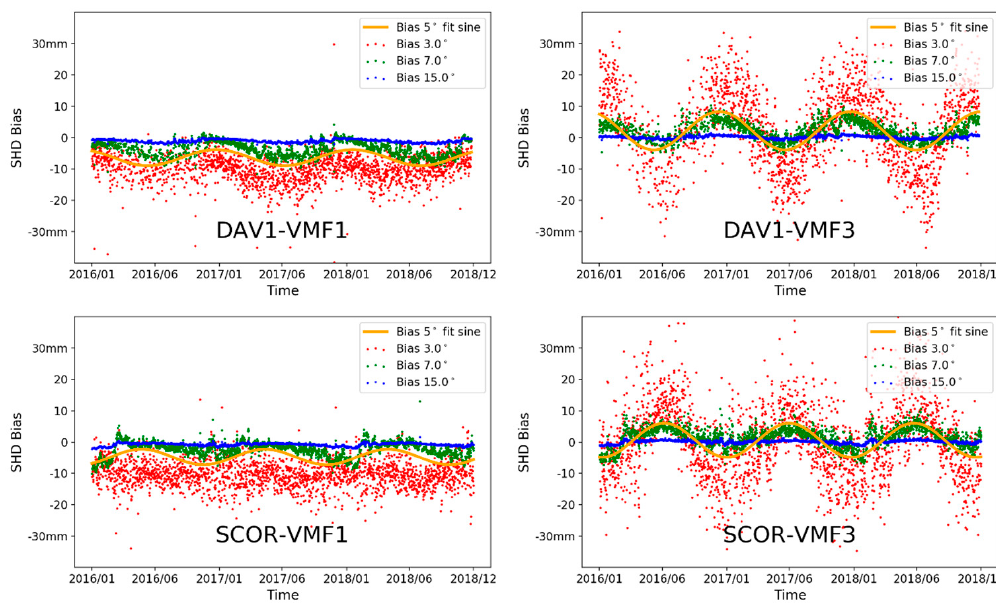
Figure 10. Time series of the biases between VMF1 and VMF3 SHD estimates with respect to radiosonde + ISA76 SHD estimates by ray-tracing for the two stations DAV1 (Antarctica) and SCOR (Iceland) for 3°, 7°, and 15° elevation angles.